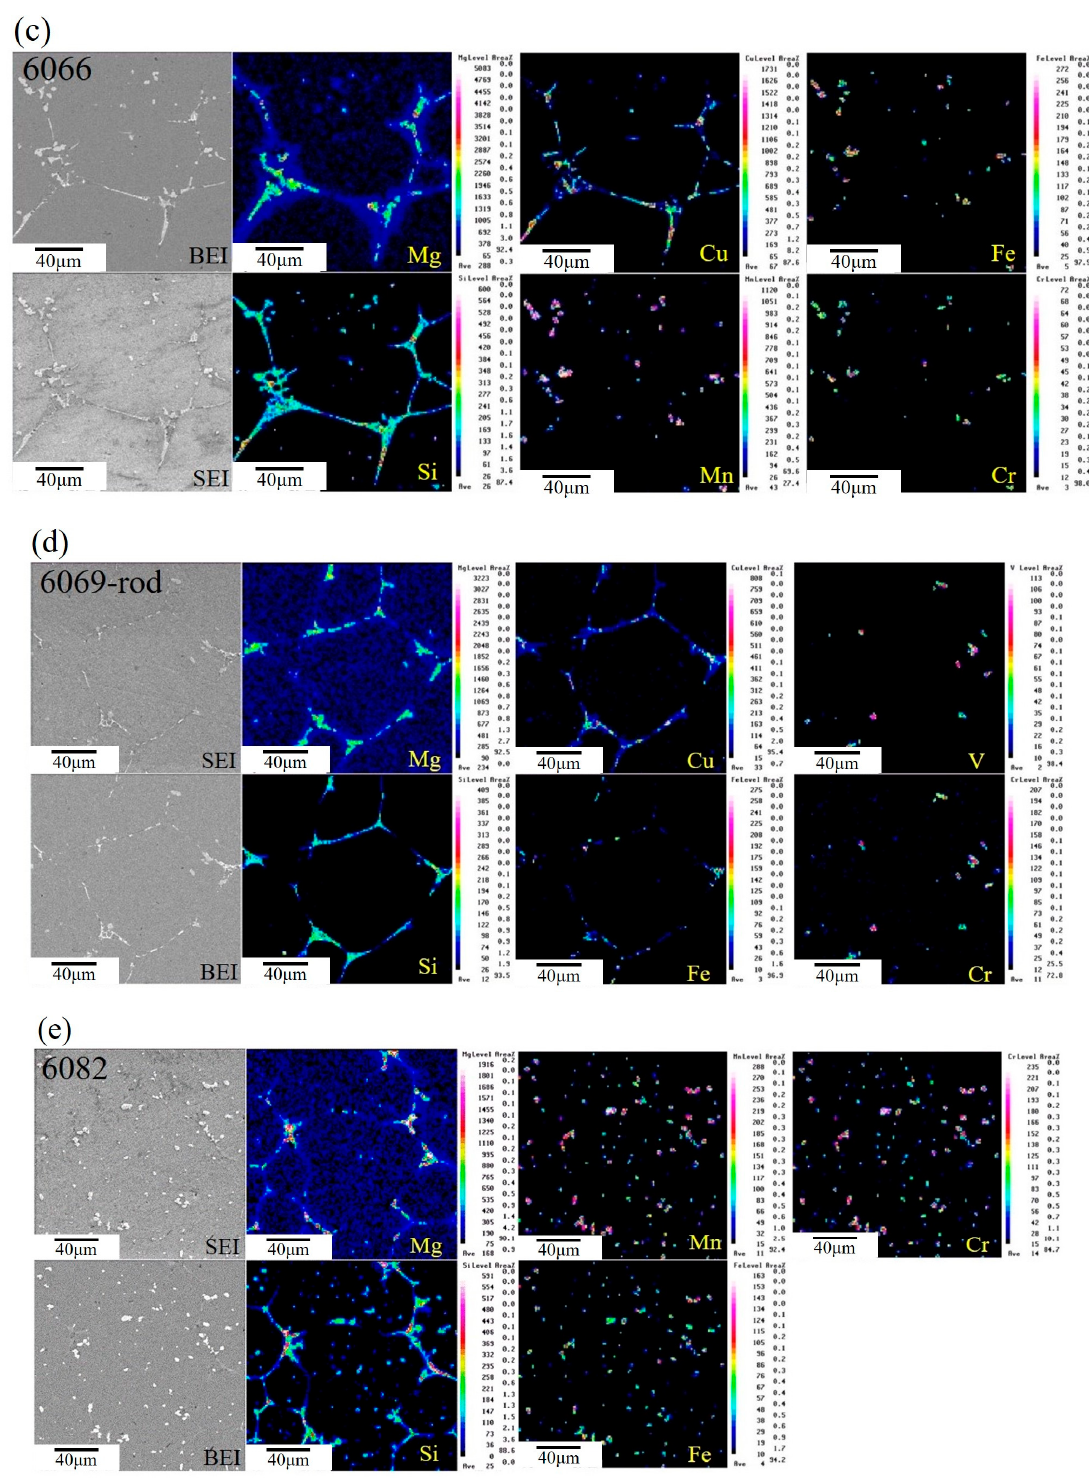
Figure 5. Elemental distribution in Al–Mg–Si alloys: ( a ) 6061; ( b ) 6061-Mn; ( c ) 6066; ( d ) 6069-rod and ( e ) 6082.